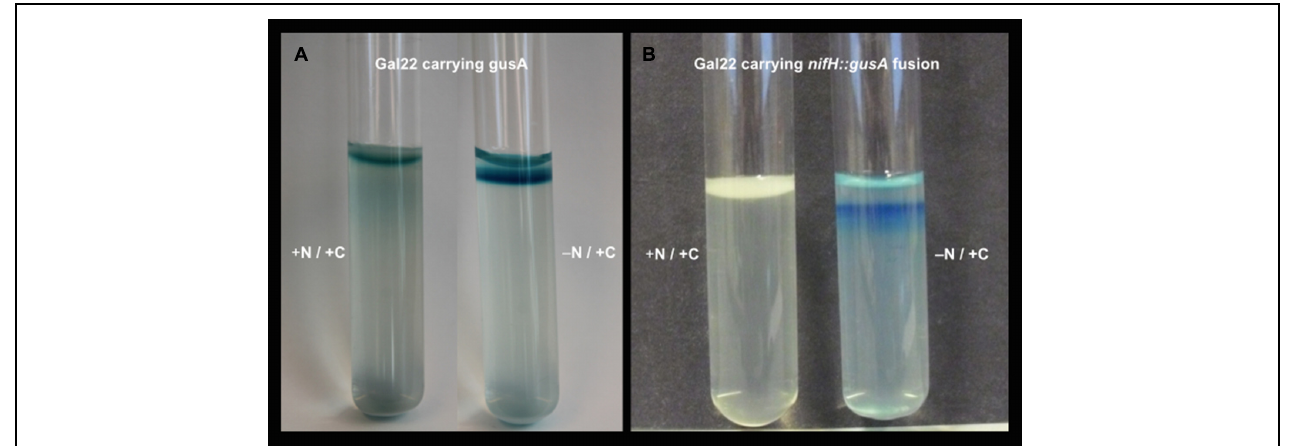
FIGURE 2 | (A) gusA -carrying transformant of Marinobacterium mangrovicola Gal22 . gusA expression is under the control of the constitutive promoter tac , and can be visualize in nitrogen-containing and nitrogen-free medium.